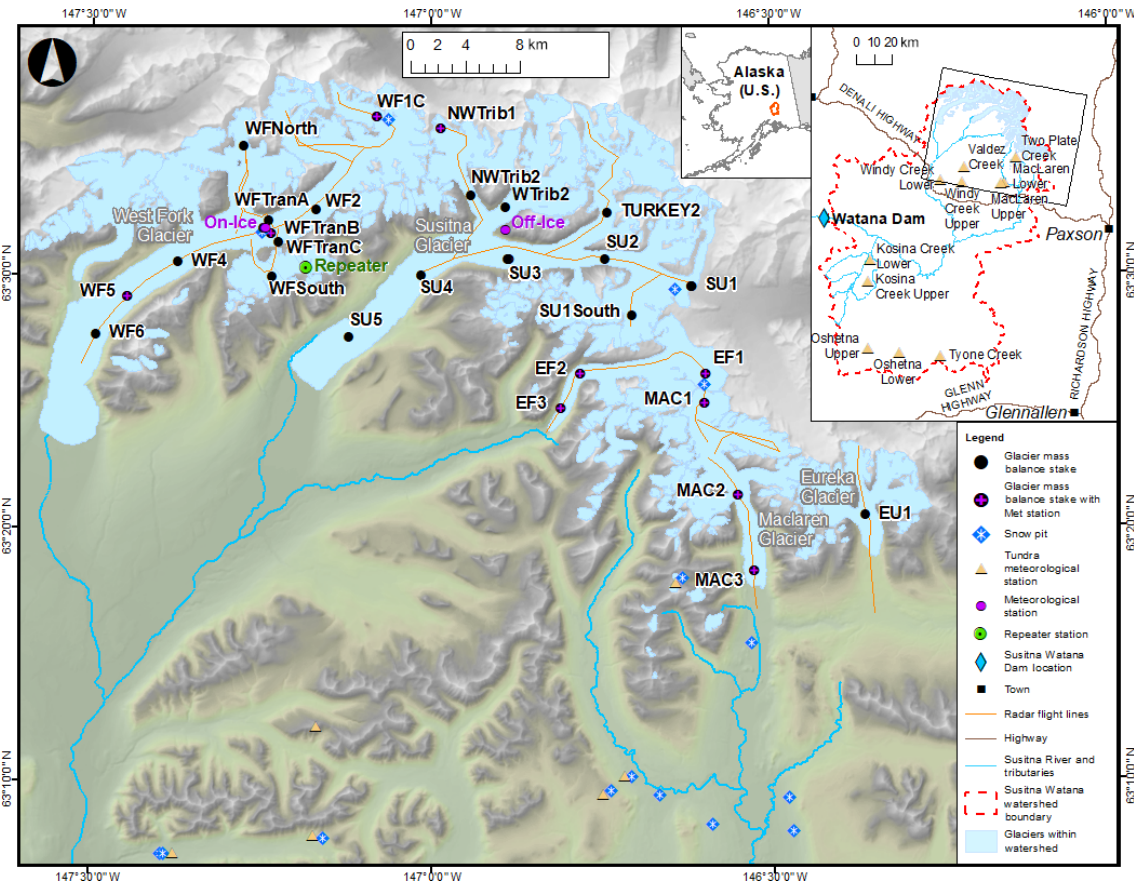
Figure 1. Map of study area including measurement locations. From west to east, the major glaciers are West Fork Glacier (stations with the prefix WF), Susitna Glacier (SU), East Fork Glacier (EF), Maclaren Glacier (MAC), and Eureka Glacier (EU). The main map focuses on the glacierized portion of the basin, the large inset shows the whole Upper Susitna basin which drains to the proposed dam site, and the small inset shows the basin in the context of the state of